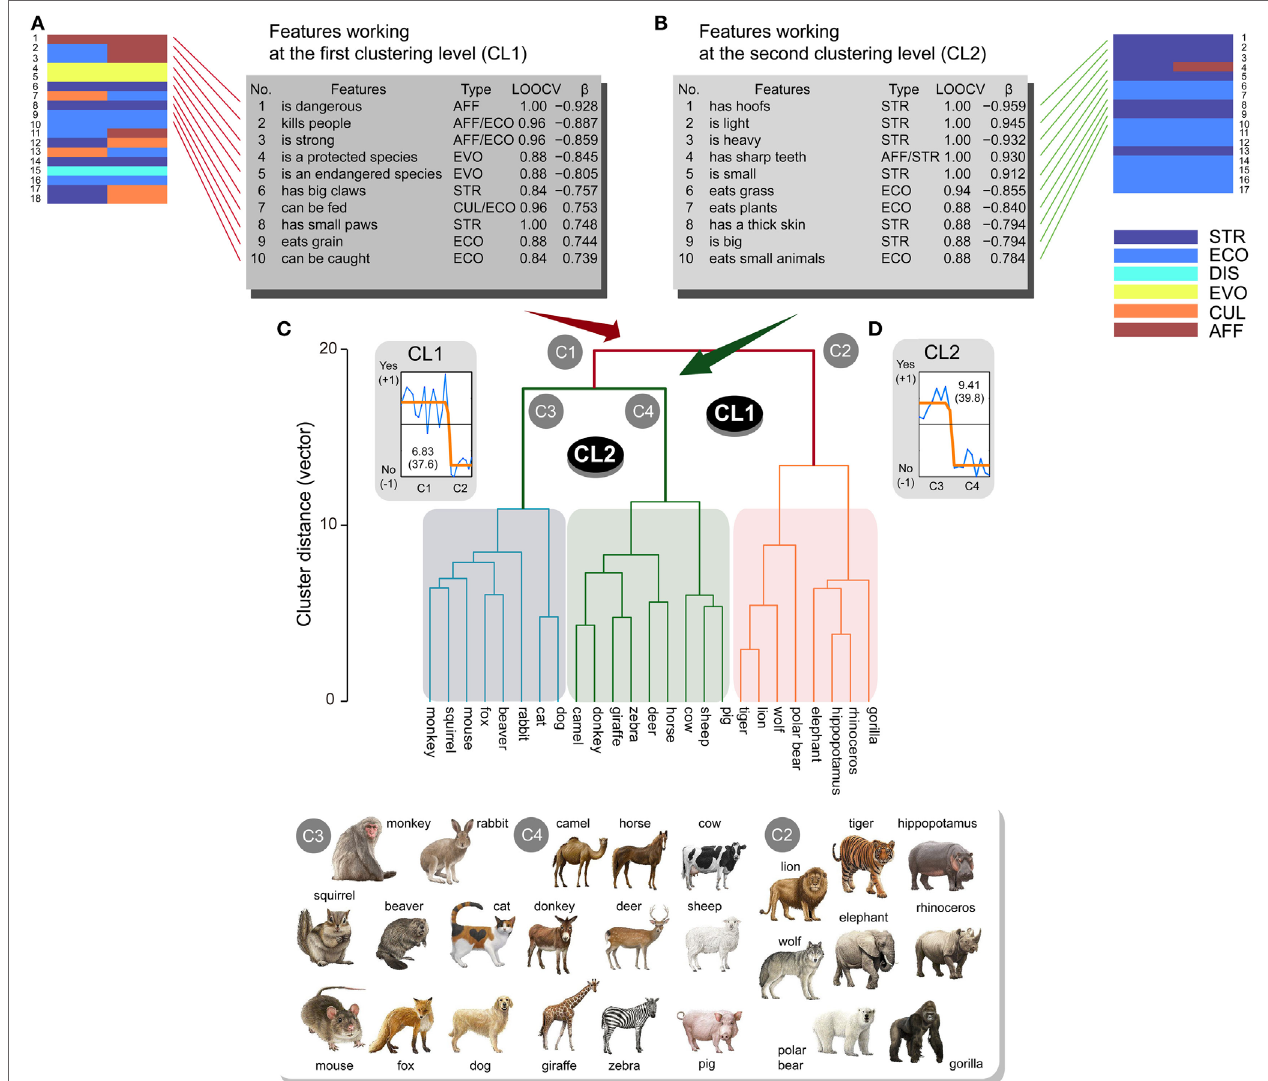
FigUre 3 | Sub-ordinate animal classification ( n = 25) for the mammal class and related features ranked within the top 10. Animals were separated into two clusters (C1, C2) at the first clustering level (CL1). The first cluster (C1) was separated into two clusters (C3, C4) at the second clustering level (CL2). Features ranked within the top 10 are listed for CL1 (a) and CL2 (B) (STR, structural; ECO, ecological; DIS, distributional; EVO, evolutional; CUL, cultural; AFF, affective) from significant features represented by colored brick charts. These features possessed high classification accuracies in leave-one-out cross-validation (LOOCV) tests and good fitting properties ( β ) to sigmoid shape functions for CL1 (c) and CL2 (D) , respectively. Higher scores on the LOOCVs indicate higher classification accuracy, and more positive and larger β coefficients represent better fitting properties. All the illustrations of animals are copyrighted by M/Y/D/S Graphics (Yokohama, Japan), which permitted us to reproduce all illustrations in the